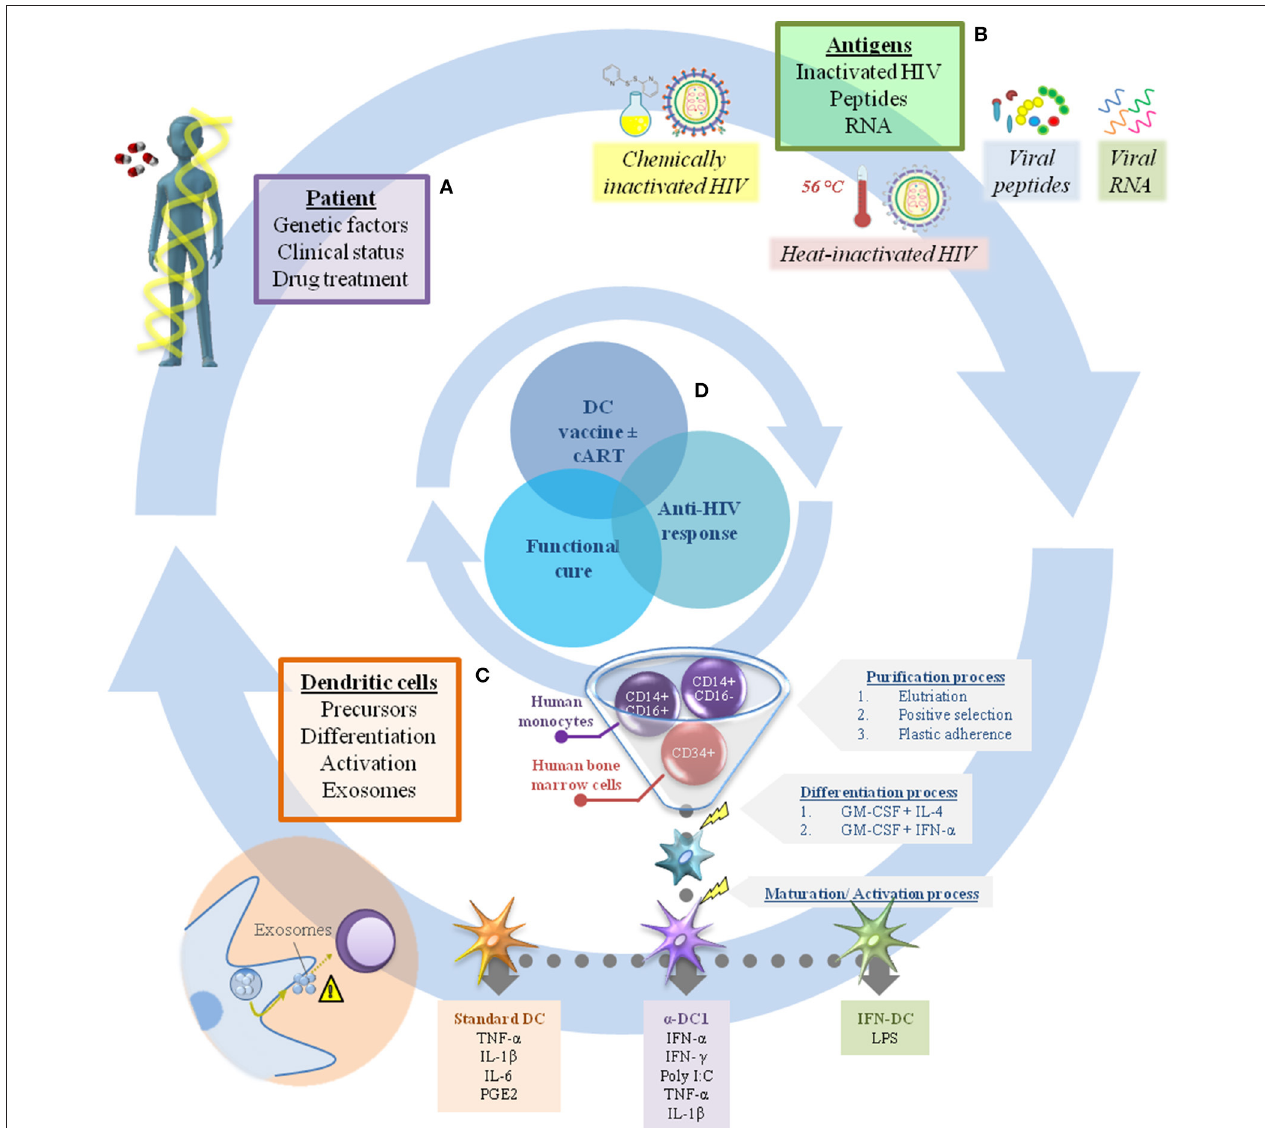
FIGURE 1 | Challenges in dendritic cell immunotherapy for HIV infection. There are many factors that should be considered in the production of DC-based vaccines to achieve a sufficient immune response against HIV combined with viral load control. In general, these can include elements related to the individual patient (A) , such as genetic factors, clinical status, and drug treatment (cART interruption or not after receiving the immunization). In addition, the range of antigens available to pulse DC is extensive, making it a challenge to choose the best one (B) . The factors related to the vaccine product (B,C) are just as important, including the choice of appropriate DC precursors (CD34 + cells or monocytes) and their differentiation/activation protocols (e.g., standard DC, α -DC1, IFN-DC), while also taking into account the potential of DC to produce exosomes (considering their role in regulation of the immune response) (C) . In this context, proper assembly of each individual gear could achieve viral infection control and make possible the “functional cure” (D)